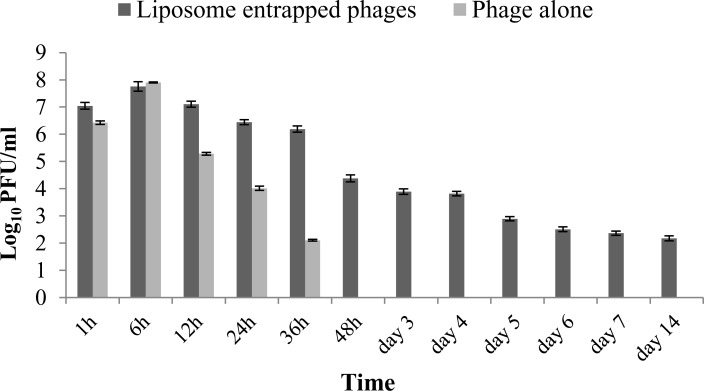
Biodistribution of liposome entrapped phage and unentrapped phage in spleen of BALB/c mice (n = 3).All values represent the mean ± SEM, calculated from two independent experiments, each performed in duplicate on different occasions